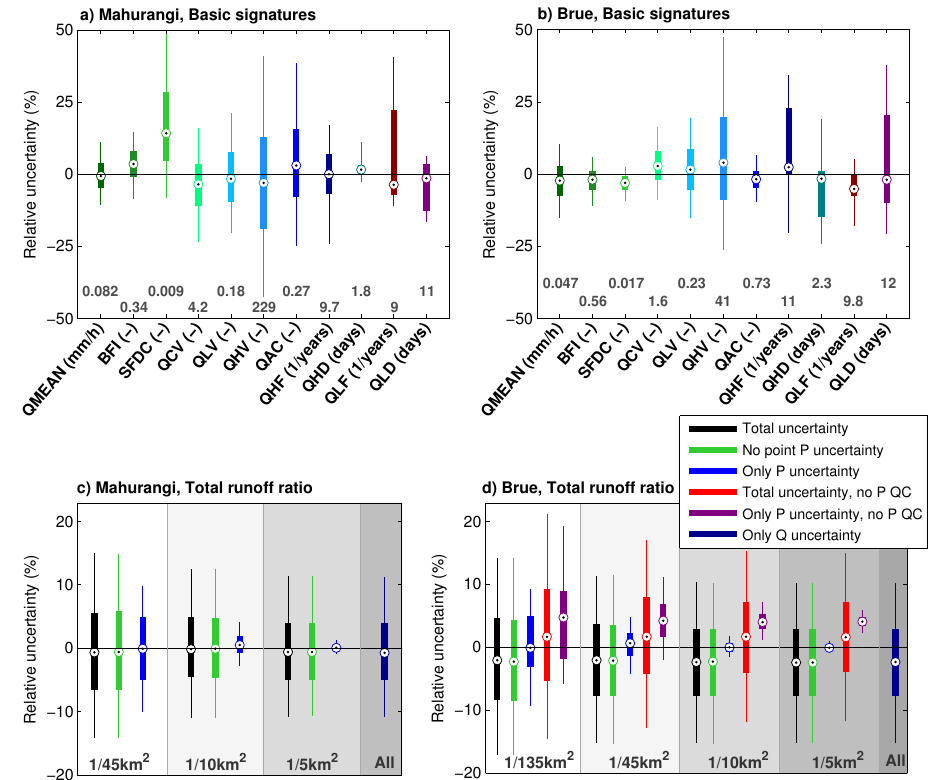
Figure 8. Relative uncertainty in basic signatures as a percentage of the signature values calculated with the optimal rating curve from the MCMC. The boxplot whiskers extend to the 5 and 95 percentiles, and the box covers the interquartile range. The signature values for the optimal rating curves are given at the bottom of the ( a and b )